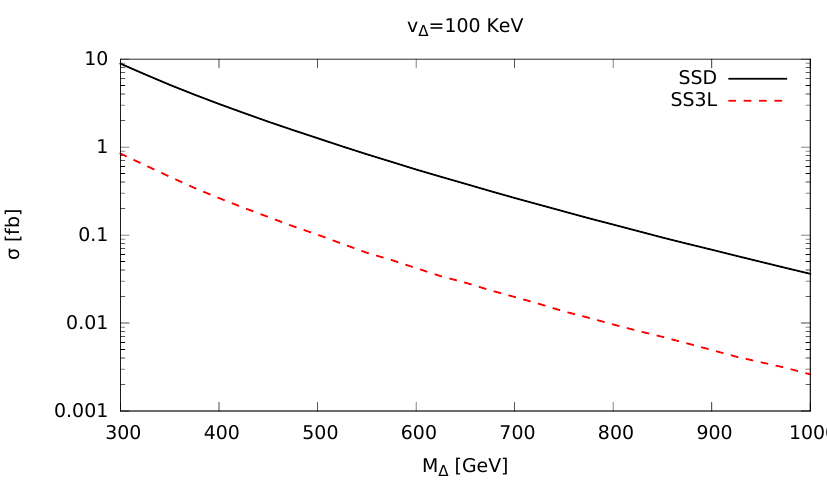
Figure 20 . Signal SSD and SS3L cross-sections after the selection cuts as a function of quadruplet mass.